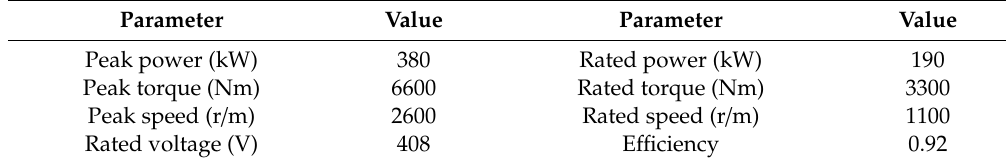
Table 4. Motor parameters.